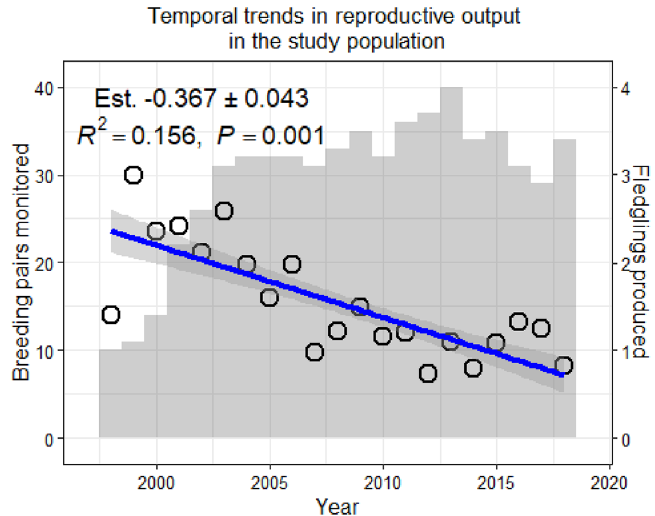
Figure 3. Temporal trends in reproductive output. Values in the plot refer to a linear model of reproductive output as a function of year, and the thick blue line shows the longitudinal trend (with standard deviation shaded) of fledglings produced by breeding individuals (β = −0.367 ± 0.043; P < 0.001; N = 617; R 2 = 0.156; Poisson GLMM with animal Id as random factor). Empty circles show the annual average number of fledglings produced. The shaded histogram in the background shows the annual sample size (breeding pairs